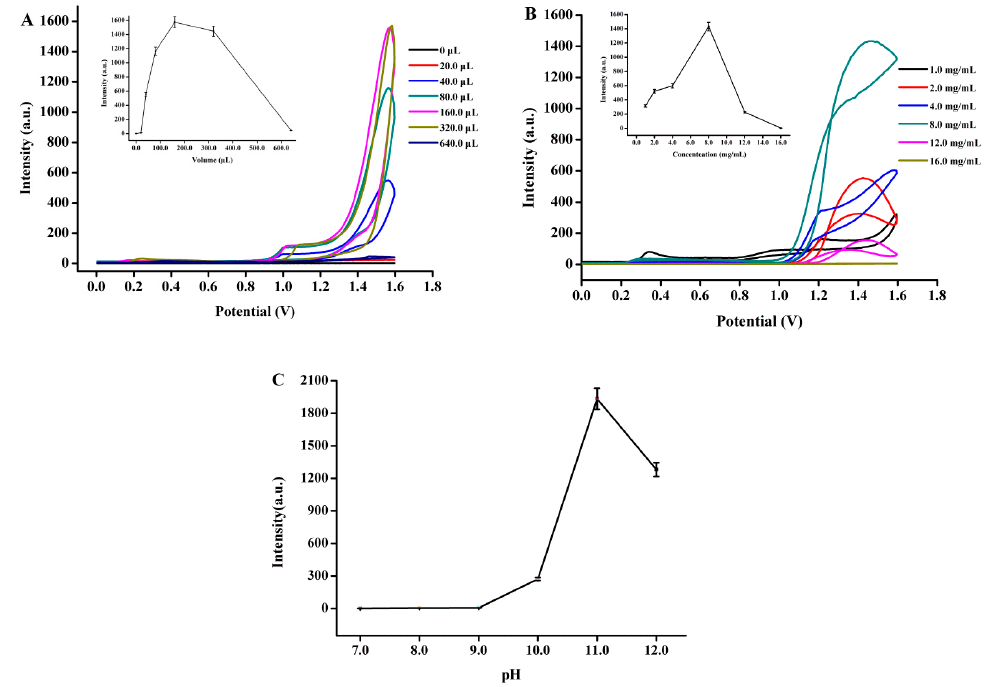
Figure 6. Effects of luminol volume ( A ), the coated concentration of Fe 3 O 4 -NCs ( B ) and pH ( C ) on ECL intensity of the developed ECL sensor based on the Fe 3 O 4 -NCs/GCE.